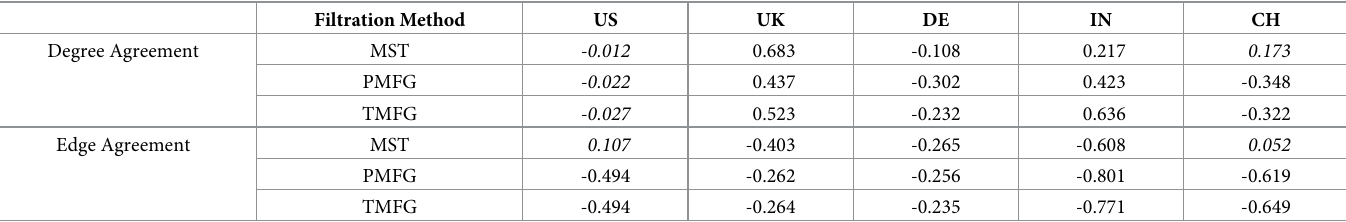
Table 1. Spearman correlation between the degree and edge agreement measures and the volatility of the market. Correlations insignificant at p < 0.05 are in italic. Filtration Method US UK